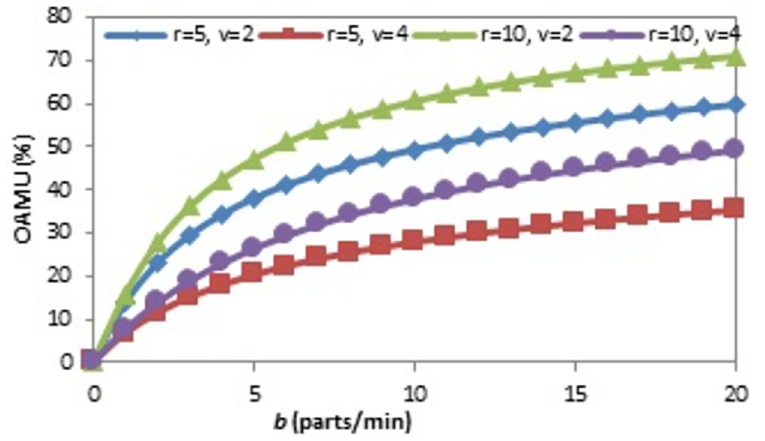
Fig 13. OAMU-b diagram for triple-machine FMC.